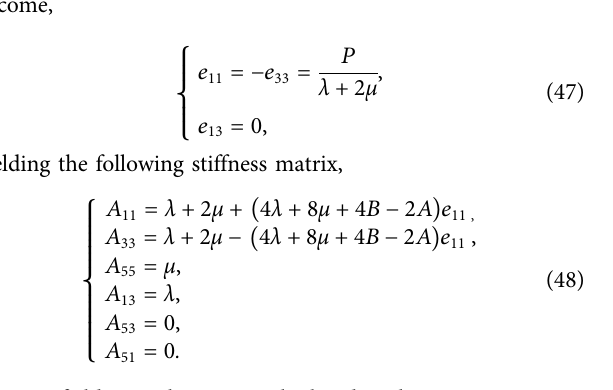
Frontiers in Earth Science |